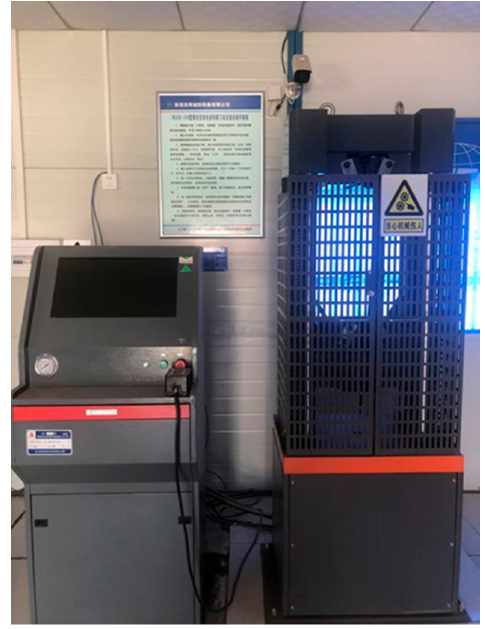
Figure 2. WAW-100 hydraulic servo universal testing machine.